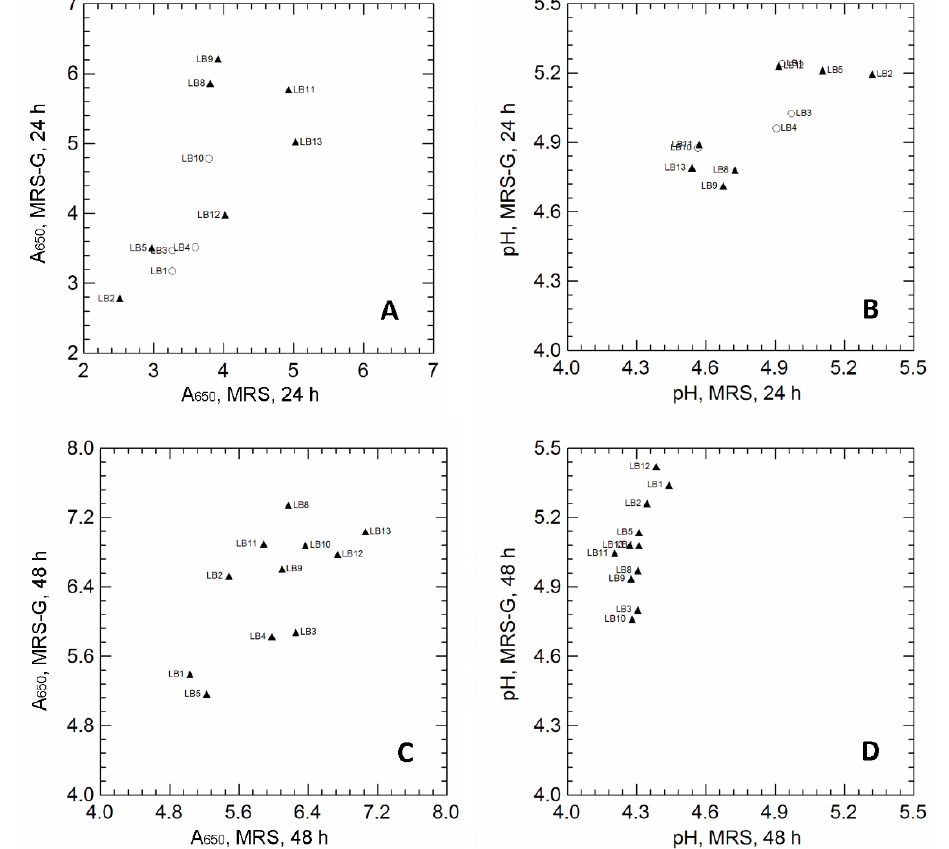
Figure 1. Panel A and B: Correlation between the A 650 values of Levilactobacillus brevis strains cultivated for 24 h ( A ) and 48 h ( C ) in unsupplemented MRS (x-axis) and MRS supplemented with 10 g/L MSG (MRS-G; y-axis). Panel B and D : Correlation between pH values measured in unsupplemented MRS (x-axis) and MRS supplemented with 10 g/L MSG (MRS-G; y-axis), inoculated with Levilactobacillus brevis strains, after 24 h ( B ) and 48 h ( D ) of incubation. Pearson’s r correlation coefficient: r = 0.697 (panel A ); r = 0.758, (panel B ); r = 0.710, (panel C ); r = 0.610, (panel D ). Symbols refer to the production of GABA, detected by TLC analysis: empty circles, no GABA spot in MRS-G samples at 24 h; filled triangles, GABA spot in MRS-G samples at 24 h; the GABA spot was missing in all unsupplemented MRS samples. Strain code: LB1 is PA11S; LB2 is PB13L; LB3 is TO62; LB4 is A7; LB5 is A4; LB8 is B02; LB9 is B17; LB10 is B25; LB11 is B29; LB12 is F02; LB13 is